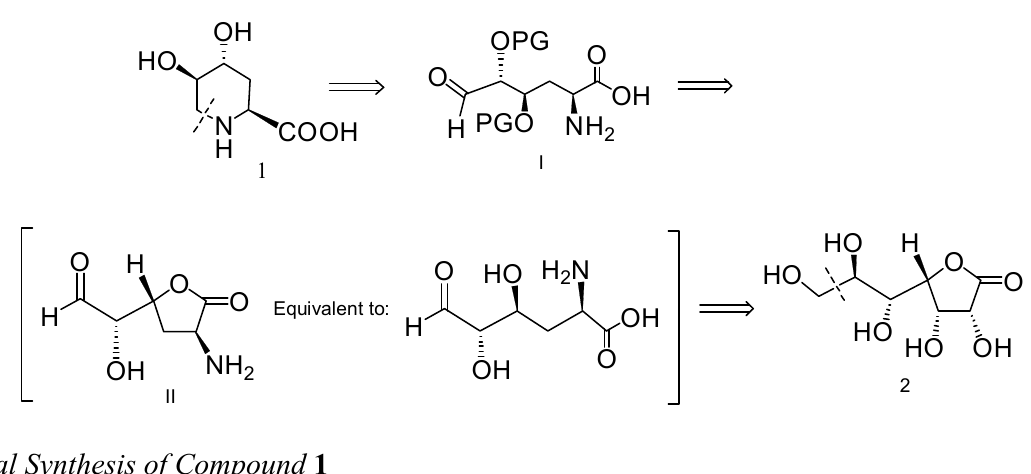
Scheme 1. Retrosynthetic analysis of the target amino acid 1